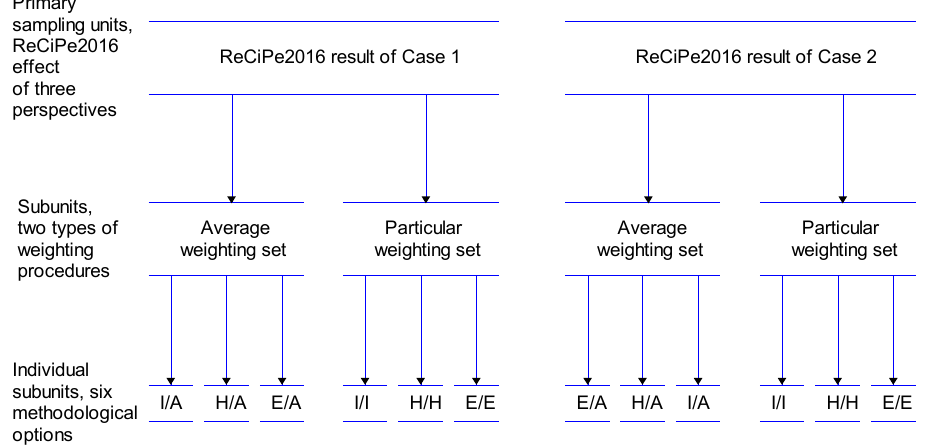
Figure 6. Two-stage analysis of variance (ANOVA) hierarchical design structure for environmental evaluation of Cases 1 and 2 (ReCiPe 2016 single-score evaluations [42]).